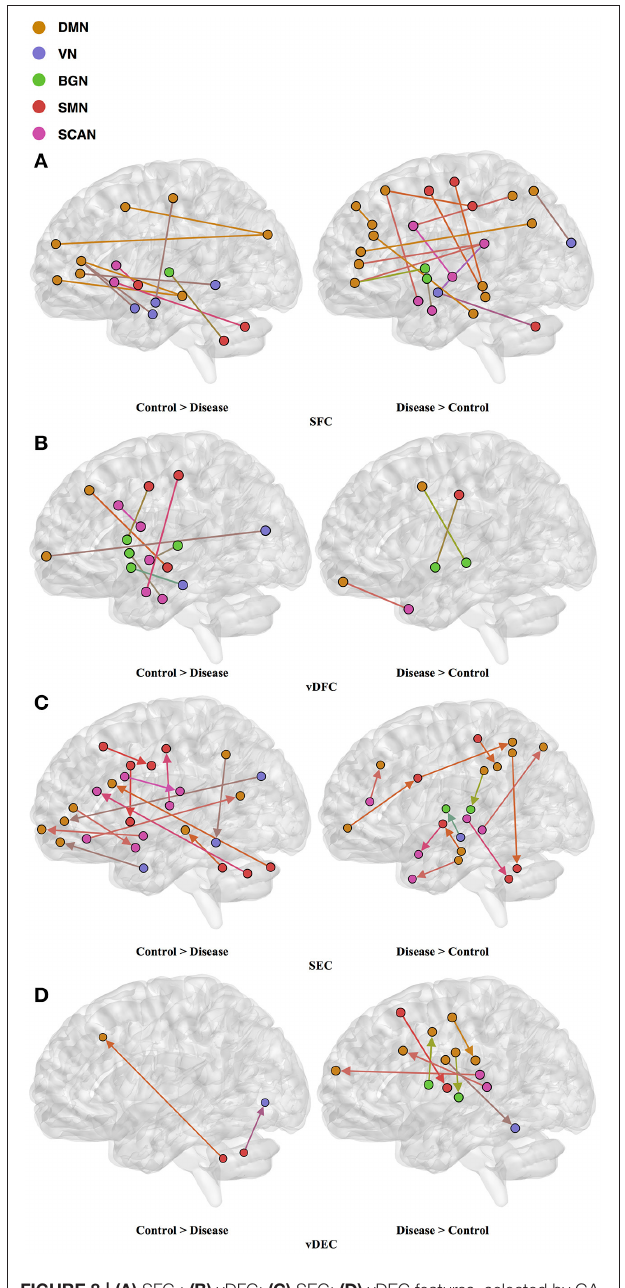
FIGURE 8 | (A) SFC ; (B) vDFC; (C) SEC; (D) vDEC features. selected by GA and hierarchical (ASD). Selected features were split into two groups, i.e., (1) control > disease (autism and asperger’s) and (2) disease > control. DMN, Default mode network; VN, Visual network; BGN, Basal ganglia network; SMN, Sensory motor network; SCAN, Semantic cognition and attention network.